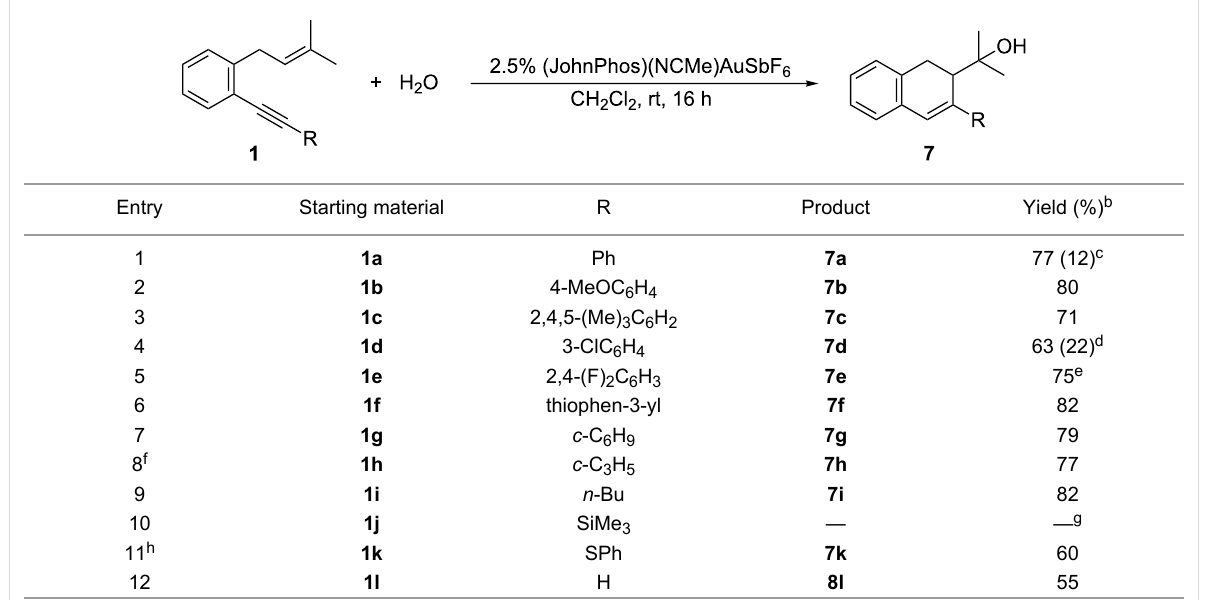
Table 2: Synthesis of 2-(1,2-dihydro-3-substituted-naphthalen-2-yl)propan-2-ol derivatives 7 by gold-catalyzed 6- endo hydroxycyclization of enynes 1 .